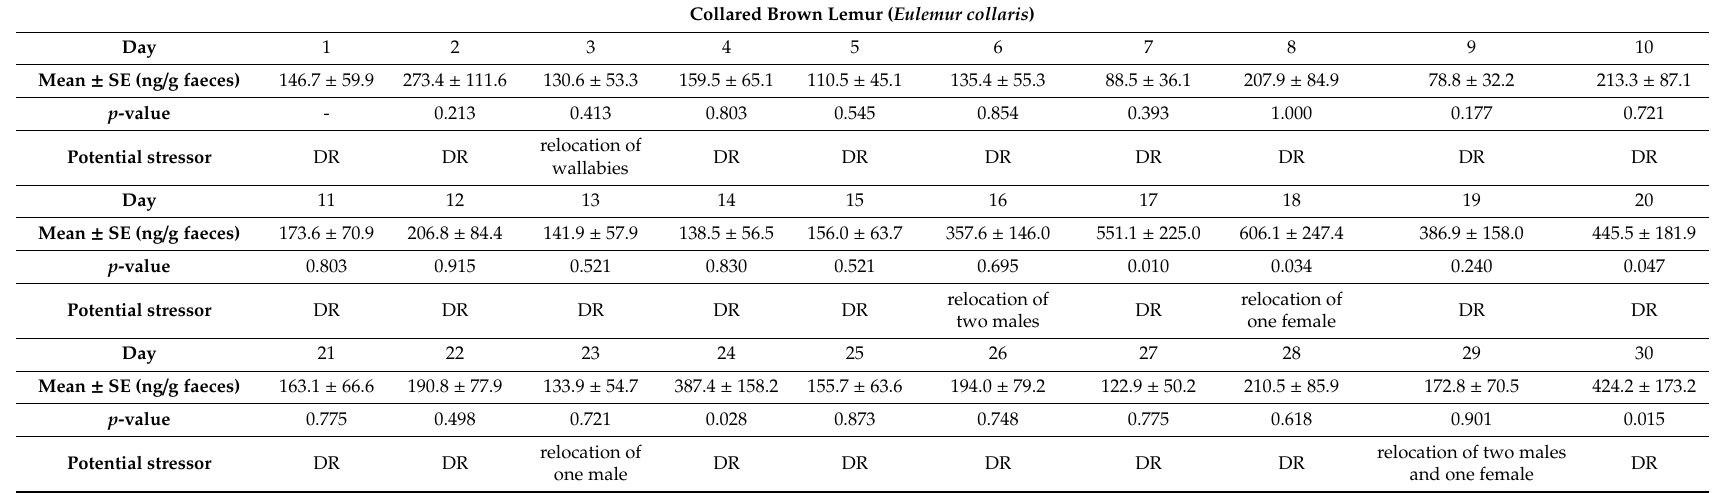
Table 4. Mean concentrations of the faecal glucocorticoid metabolites (FGMs) in collared brown lemurs and potentially stressful events for each day of